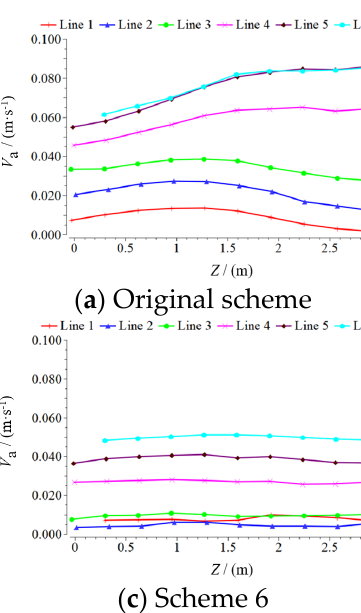
( d ) Scheme 7 Figure 16. Diagram of axial velocity on the inlet of the sump 4#. Figures 17–20 are the axial velocity chart before the bell mouth in the sump. In Figure 17a, the axial velocity decreases at a depth of 0.6 m, which is similar to the inlet of the sump. In Figure 17b,c, it is obvious that the axial velocity of each layer at the bell mouth is close to each other without obvious fluctuations by rectification. In Figures 18 and 19,